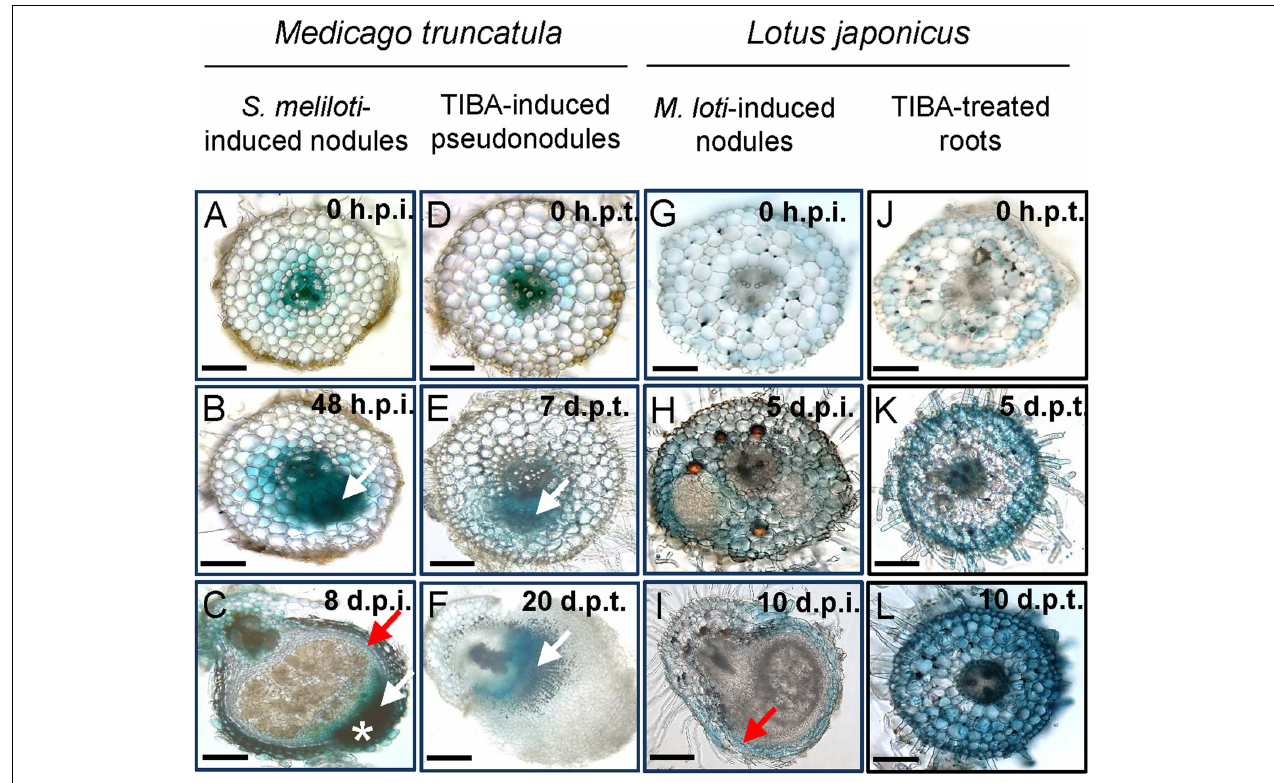
FIGURE 7 | Auxin response as seen by GH3:GUS expression in M. truncatula and L. japonicus roots or nodules. Auxin response in different tissues in (A–C) S. meliloti -induced nodules on M . truncatula roots; (D–F) TIBA-induced pseudonodules on M . truncatula roots; (G–I) M. loti -induced nodules on L . japonicus roots; and (J–L) TIBA-treated roots of L . japonicus . The developmental stages are indicated by the time after S. meliloti /TIBA/ M . loti treatment in each case. White arrows indicate auxin response in dividing cells. Red arrow indicates auxin response in the nodule vasculature. White asterisk indicates the location of the nodule meristem, where an enhanced auxin response is observed. Scale bars represent 200 µ m. Abbreviations: h.p.i., hours post-inoculation; d.p.i., days post-inoculation; h.p.t., hours post-treatment; and d.p.t., days